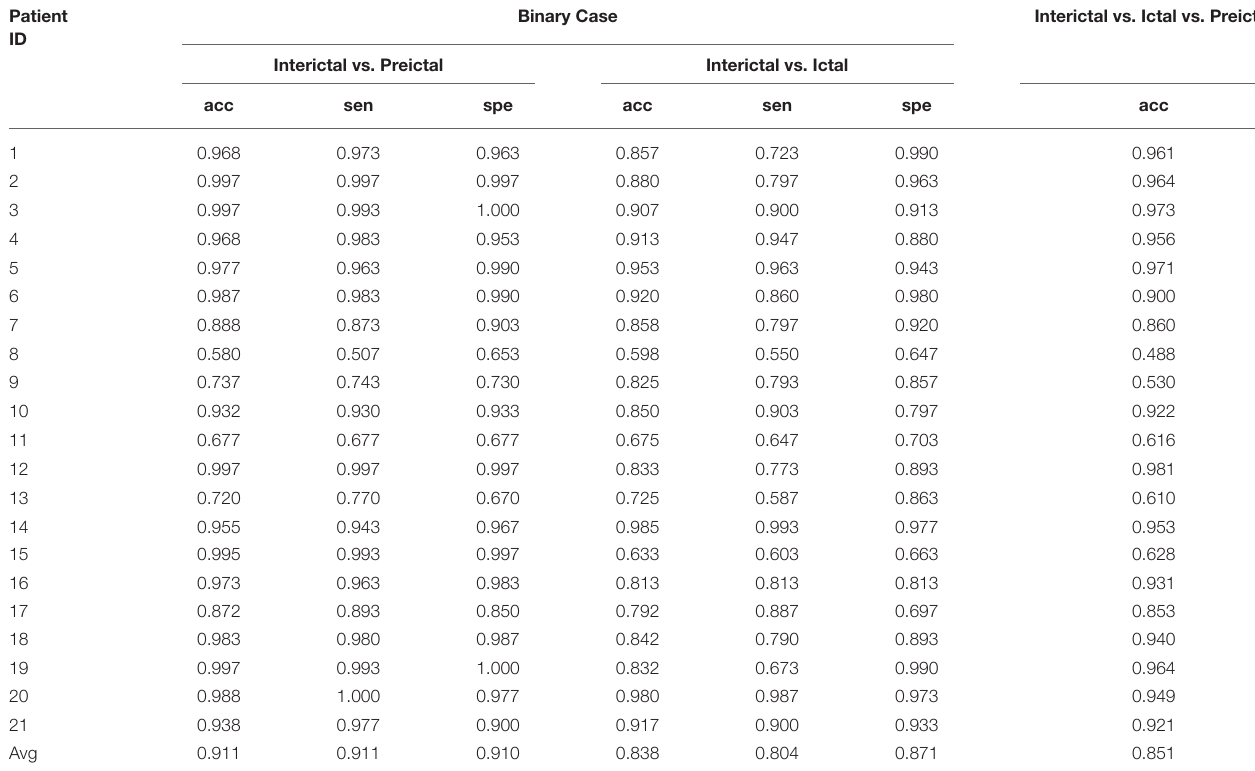
TABLE 2 | Time domain signal results for all patients in the Freiburg database. Patient